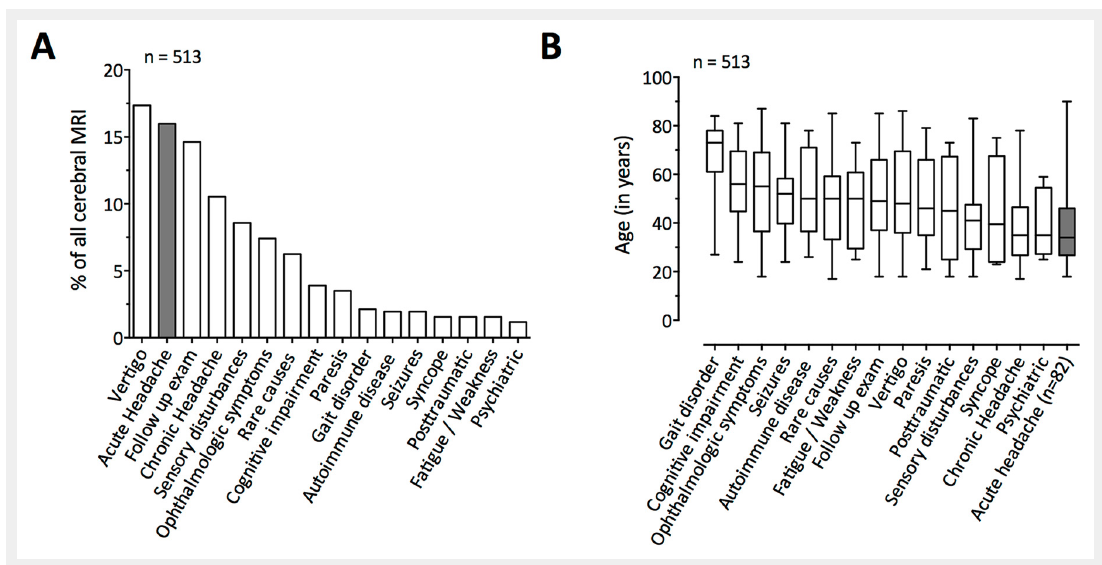
Figure 1 Acute headache is a leading indication for cerebral magnetic resonance imaging (MRI) in medical outpatients. (A) Indications for brain MRI referrals at our medical outpatient clinic are displayed. Indications were ranked by % of all ordered brain MRI during the study period. Absolute numbers and more detailed definitions are listed in table S1 (appendix). (B) Age distribution per indication is displayed, ranked by decreasing age. The line indicates the median age, the box the secondand third quartiles, and the whiskers indicate the